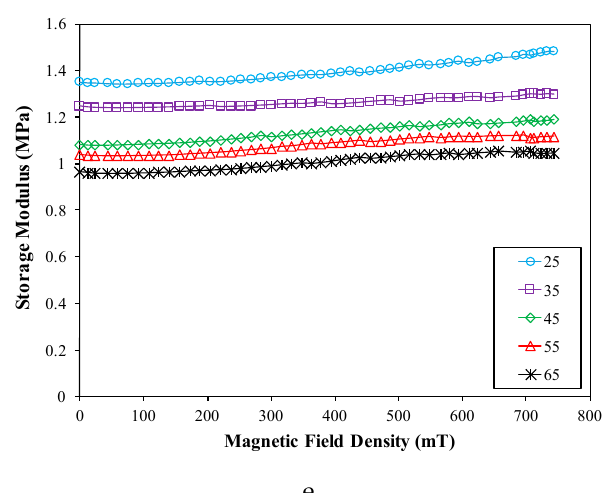
Figure 7. The storage modulus of the ENR-based MREs: ( a ) 0 wt %, ( b ) 10 wt %, ( c ) 30 wt %, ( d ) 50 wt %, and ( e ) 70 wt % of CIPs.